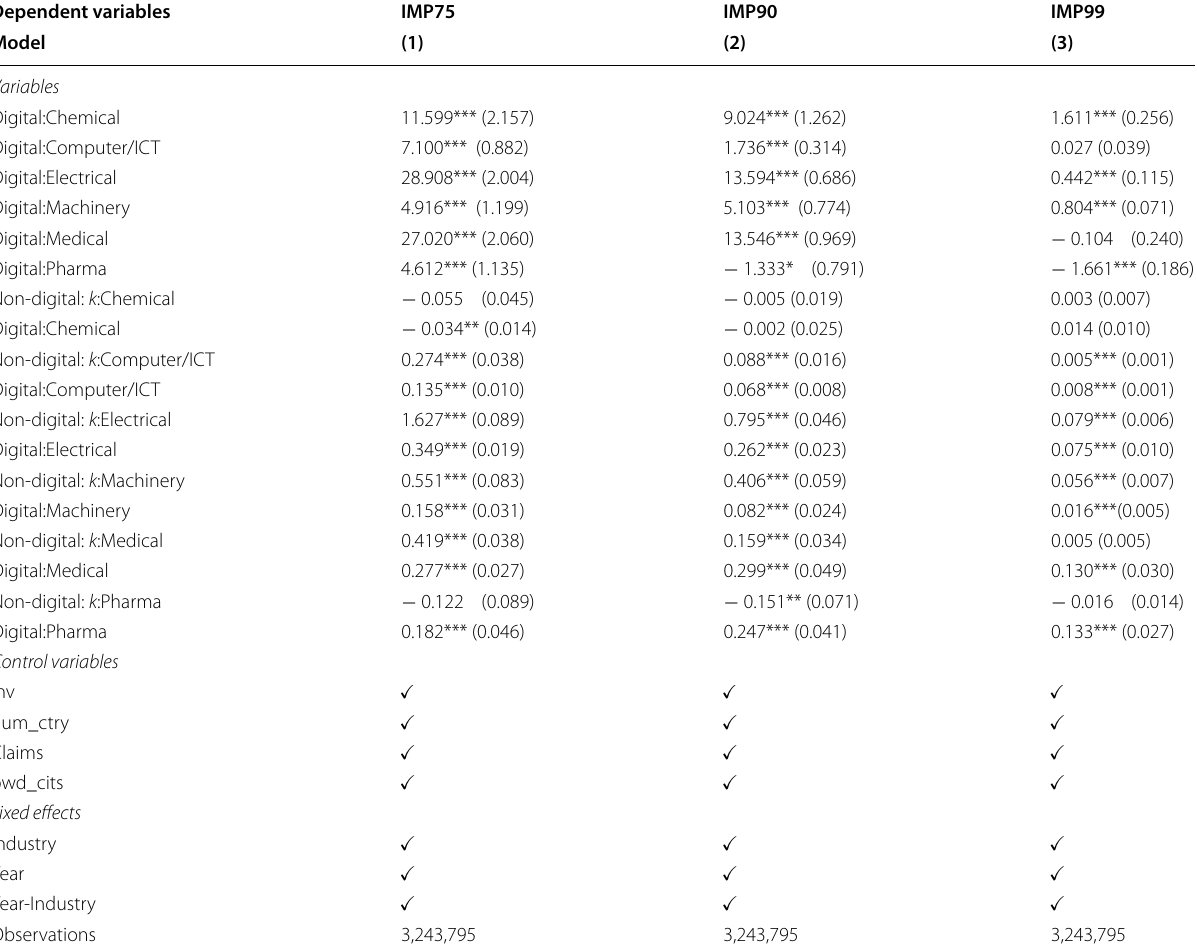
Table 14 Technological improvement rates and breakthrough innovations: breakthrough measures across industries (part